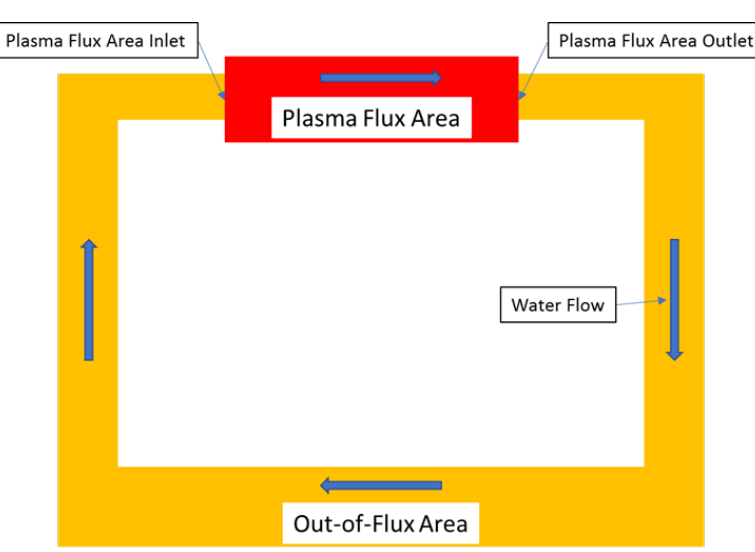
Figure 30. Simplified representation of the IBED PHTS.